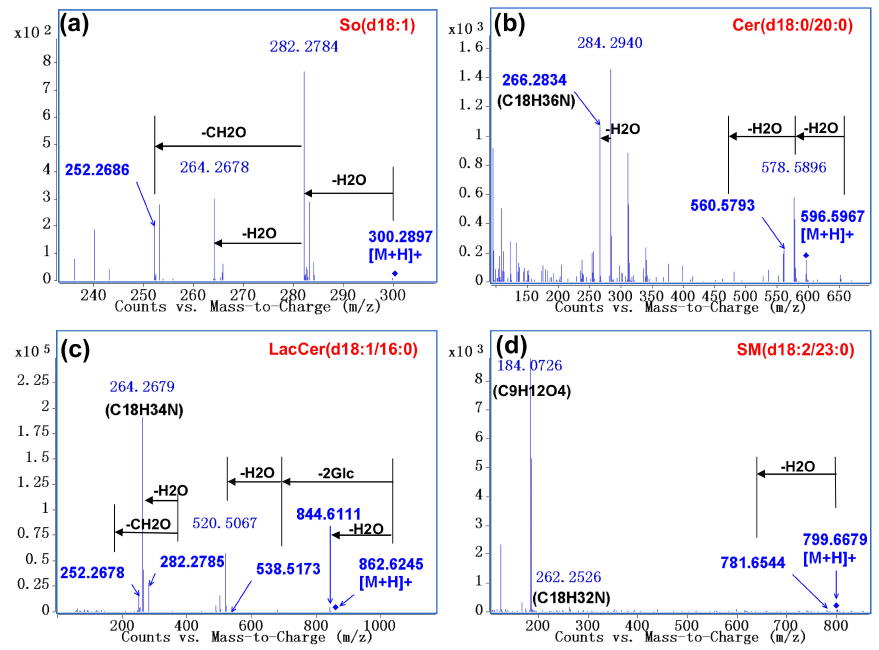
Figure 2. Characteristic MS/MS spectra of ( a ) So (d18:1); ( b ) Cer (d18:0/20:0); ( c ) LacCer (d18:1/16:0); and ( d ) SM (d18:2/23:0) by Q-TOF-MS analysis. So, sphingosine; Cer, ceramide; LacCer, lactosylceramide; SM,